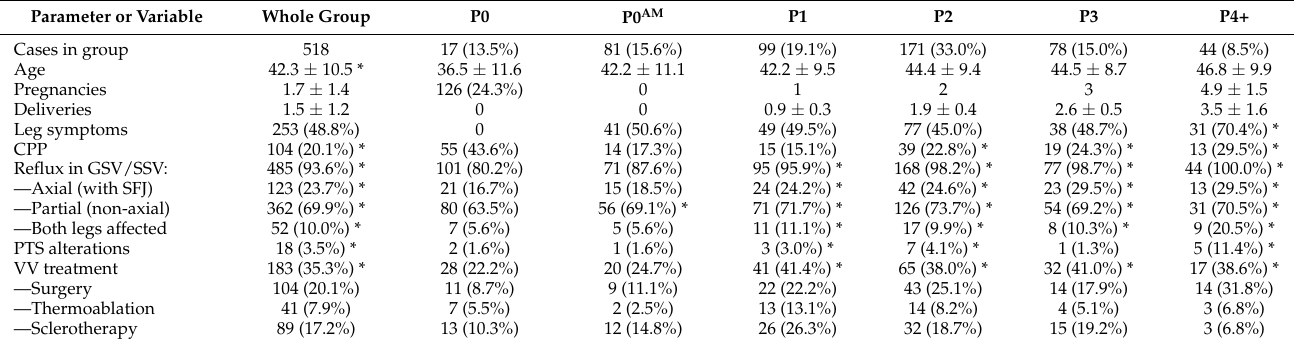
The values shown in the table represent mean ± SD, or the number (percent) of cases in the respective group. Abbreviations: SD: standard deviation, CPP: chronic pelvic pain, GSV: great saphenous vein, SSV: small saphenous vein, SFJ: saphenofemoral junction, PTS: post-thrombotic syndrome, and VV: varicose veins. The values marked with asterisks (*) are significantly different compared to the corresponding values in the P0 AM